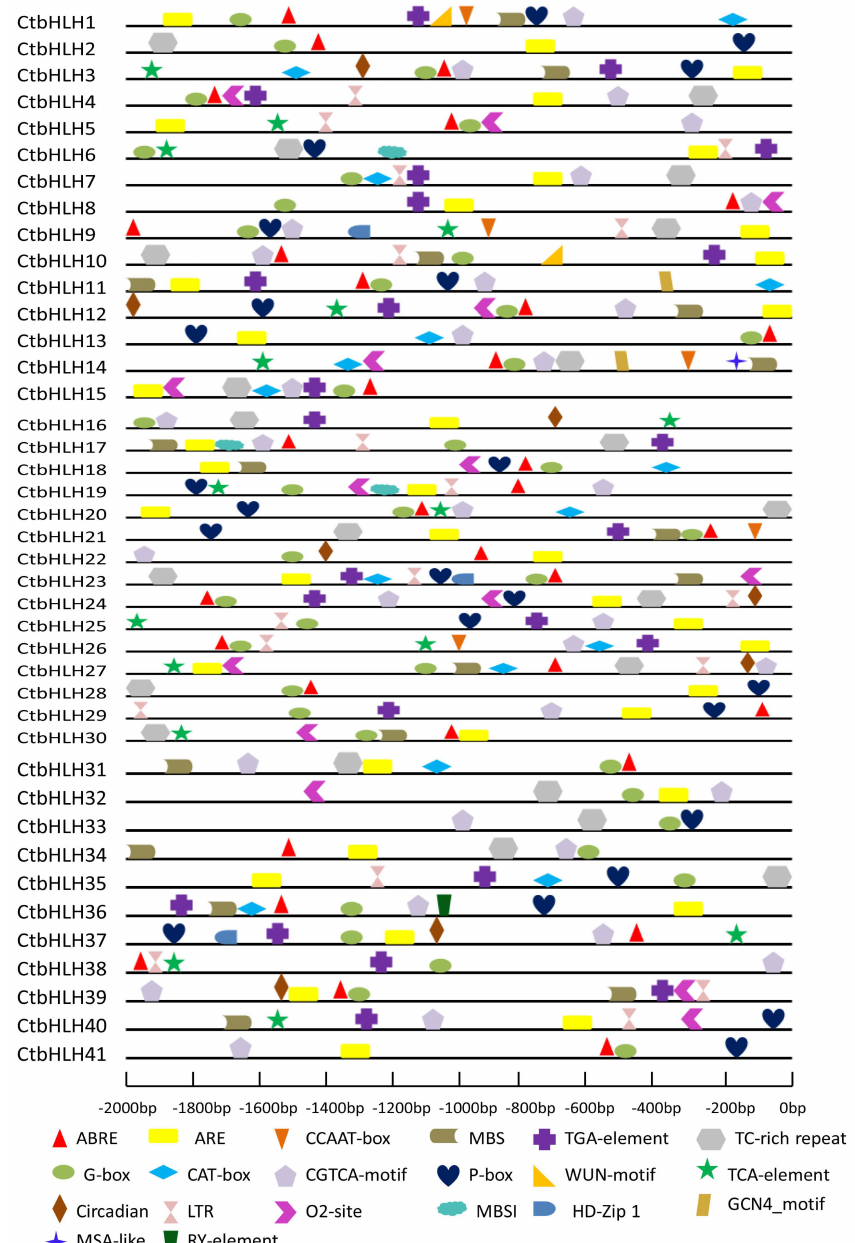
Figure 7. Illustration of 20 selected cis-regulatory units in all promoters of sa ffl ower bHLH genes. From the translation start site, the upstream region from − 2000 to − 200 shows the upstream region of each bHLH promoter. Several units, including ABRE, G-box, CGTCA-motif, P-box, and TC-rich repeats, exist in the